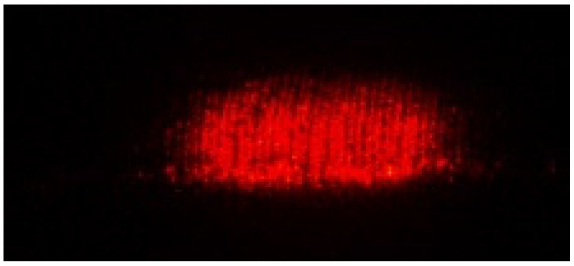
Figure 5. Laser speckle pattern [10].